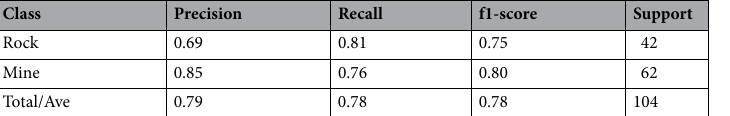
Table 4. The network’s performance is obtained based on the test data corresponding to the balanced